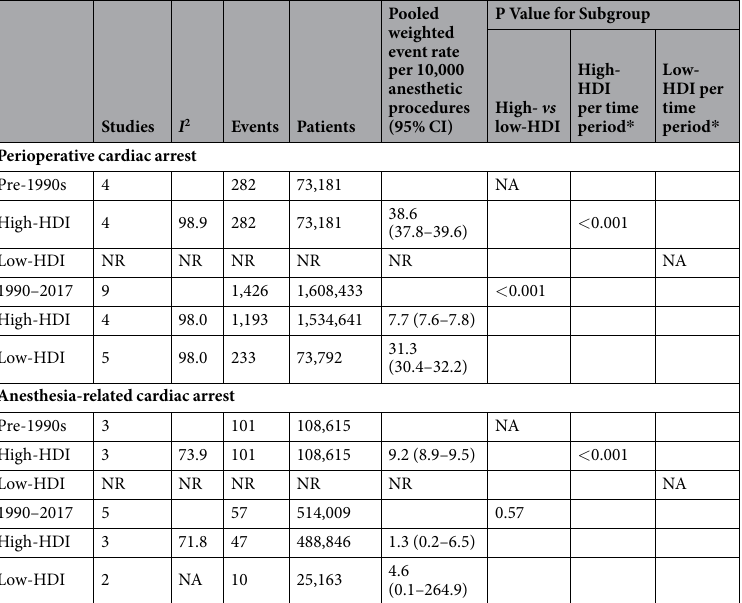
Table 2. Perioperative and anesthesia-related cardiac arrests by time period and by human development index (HDI) status. Abbreviations . I 2 : heterogeneity among studies; CI: confidence interval; NR: not reported; NA: not available; vs : versus ; * Pre-1990s versus